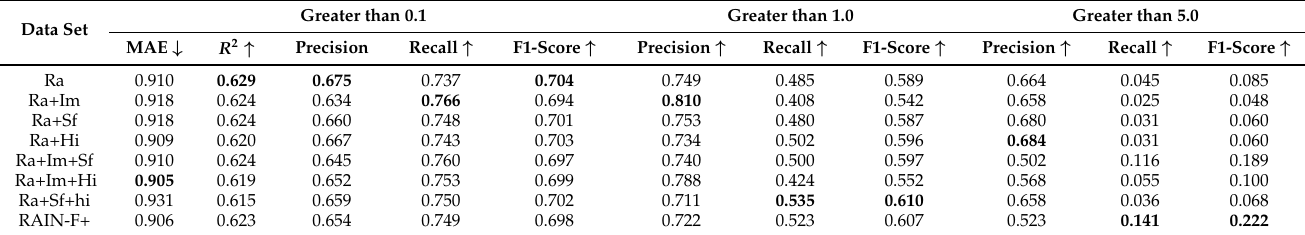
Table 2. Evaluation results for precipitation prediction in next one hour with the resolution of 64 × 64. Data Set